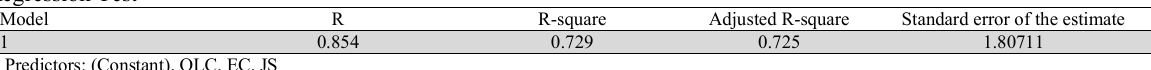
Regression Test Model